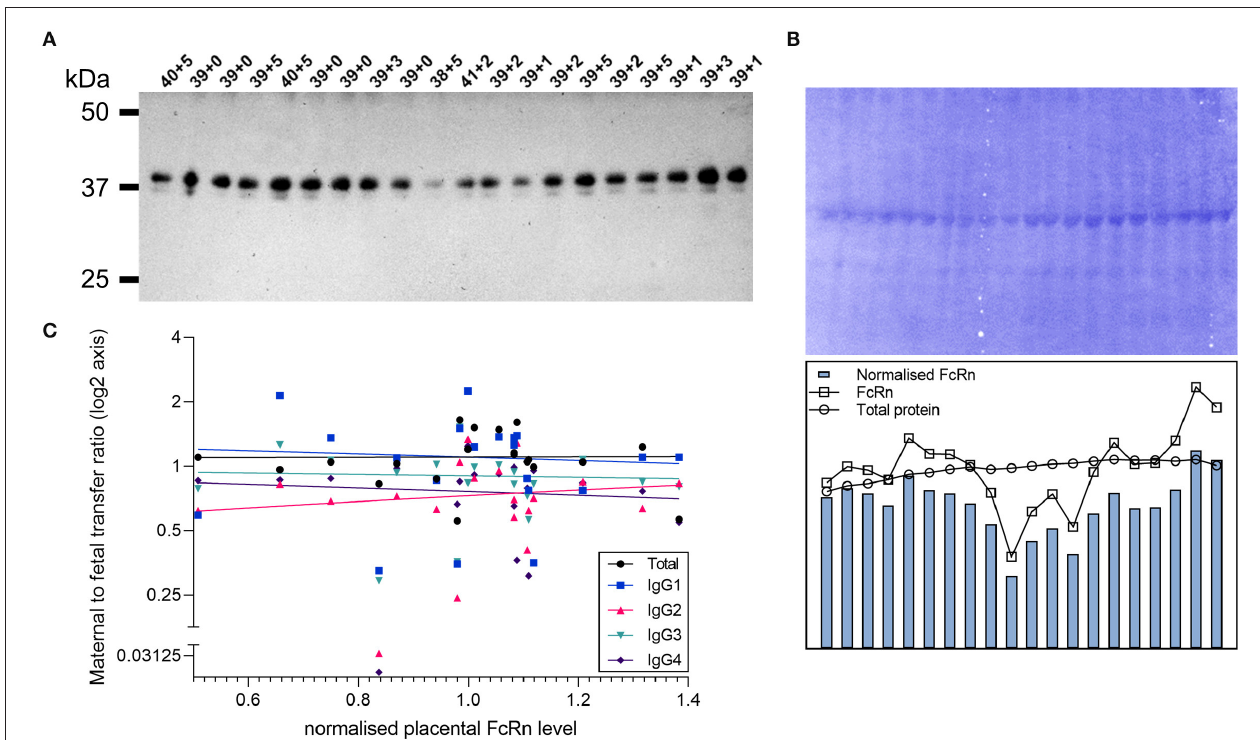
FIGURE 5 | Correlation of placental FcRn levels with transfer of IgG subclasses. (A) Western blot for FcRn in lysates of placental villous tissue. Proteins were prepared under reducing denaturing conditions. Top labels indicate gestational age of the sample in weeks + days. (B) Total protein stain (left panel) and densitometry analysis (right panel). (C) Correlation between placenta FcRn protein levels (normalized to total protein stain) and maternal to fetal IgG transfer ratios (log(2) transformed) analyzed by Spearman’s rank correlation coefficient. All correlations non-significant at p > 0.05 level (Total IgG p = 0.51, Spearman r 0.156; IgG1 p = 0.80, r = − 0.062; IgG2 p = 0.54, r = 0.146; IgG3 p = 0.67, r = − 0.101; IgG4 p = 0.26, r = − 0.266). N = 20.